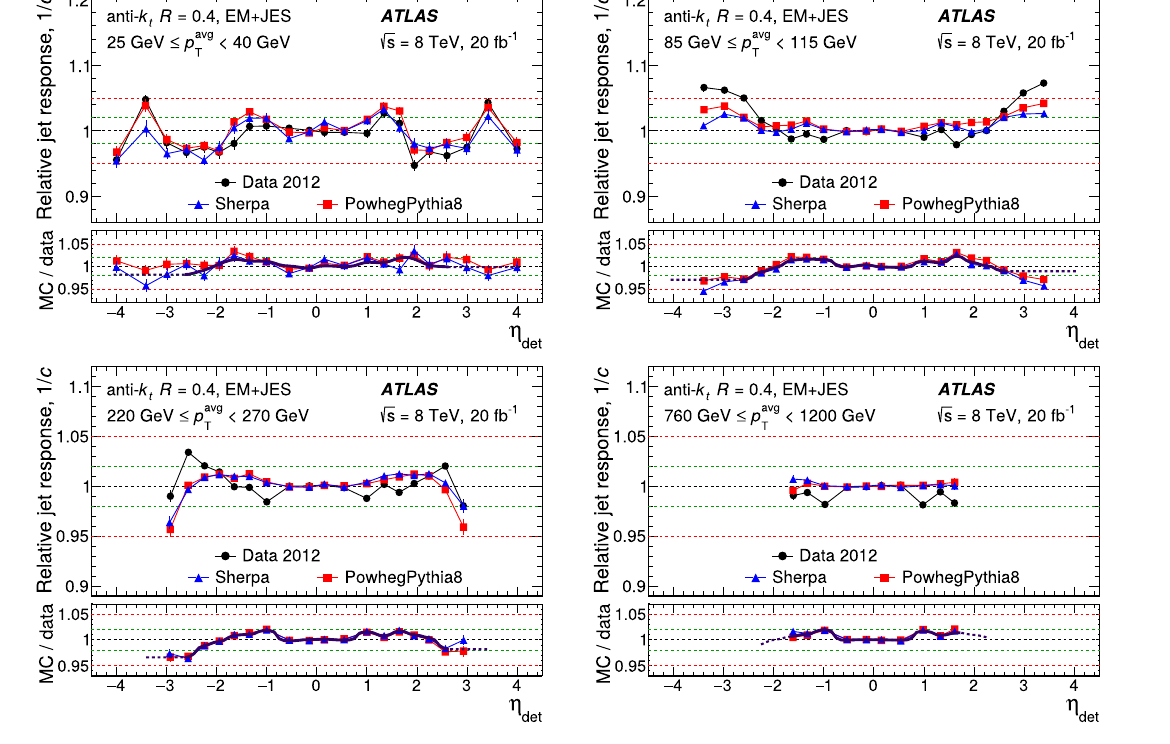
Fig. 17 Relative jet response, 1 / c , as a function of the jet pseu- associated statistical uncertainties. The lower part of each figure shows dorapidity for anti- k t jets with R = 0 . 4 calibrated with the the ratio of relative response in MC simulation to that in data, while the EM+JES scheme, for data (black circles), Sherpa (blue triangles) thick line indicates the resulting residual correction. The dashed part of and Powheg+Pythia8 (red squares). Results are shown separately this line represents the extrapolation of the ratio into regions which are < 40 GeV, 85 GeV < p avg < 115 GeV, for 25 GeV < p avg either statistically limited or probe | η det | > 2 . 7. These measurements T T < 270 GeV and 760 GeV < p avg < 1200 GeV with are performed using the matrix method. The dashed lines in the lower 220 GeV < p avg T T panels indicate 1 ± 0 . 02 and 1 ± 0 .